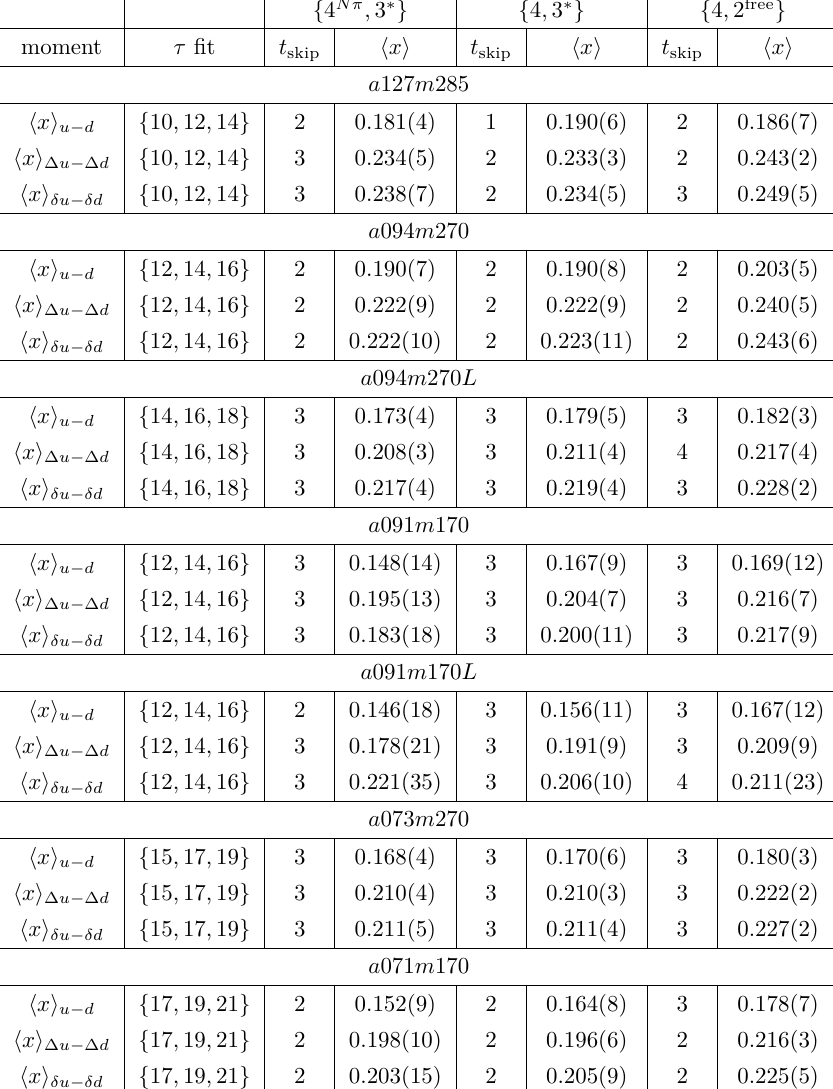
Table 6 . Unrenormalized moments on the seven ensembles from the three fit strategies, { 4 Nπ , 3 ∗ } , { 4 , 3 ∗ } and { 4 , 2 free } , used to analyze the ESC in the three-point functions. For each fit strategy, we give the cuts on the data: the common values of τ used in the fits, and the number of time slices t skip omitted next to the source and the